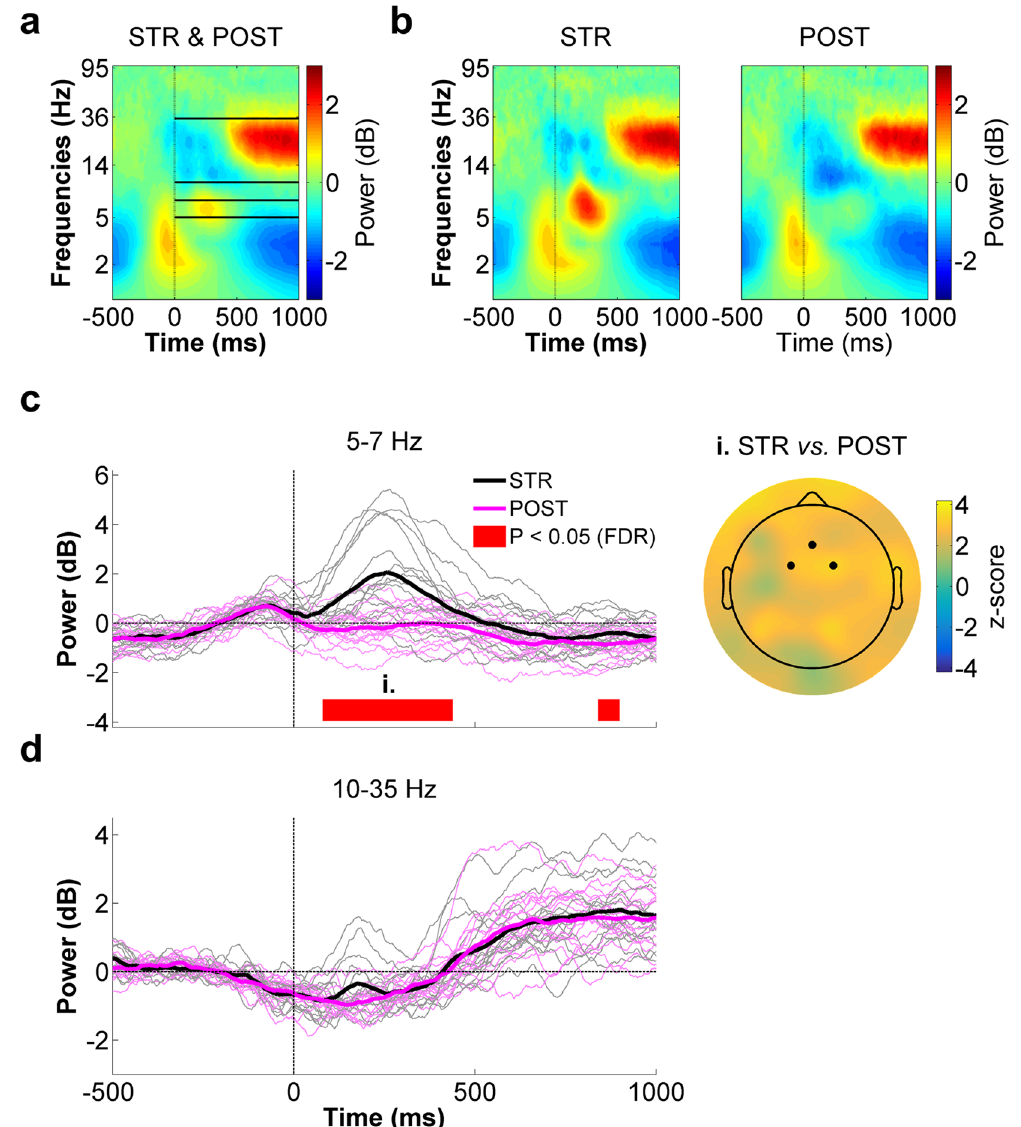
Figure 8. Mid-frontal ROI time-frequency data for STR vs . POST. ( a ) Spectrogram representing the mean ERSPs for STR and POST. The solid lines delimit the frequency bands selected for statistical analyses ( i.e . 5–7 Hz and 10–35 Hz) Time “0 ms” corresponds to movement onset. ( b ) STR (left panel) and POST (right panel) ERSPs. ( c ) High theta (5–7 Hz) spectral power time-course for STR (black) and POST (magenta) (left panel). The red line highlights the time bins showing statistically significant differences between STR and POST ( p ≤ 0.05, FDR-corrected). The scalp map (right panel) represents the statistical z-scores across electrodes for high theta power differences between STR and POST during the significant time window (i., 80–440 ms). The highlighted electrodes denote those that make up the mid-frontal ROI (Fz, FC1 and FC2). ( d ) Beta (10–35 Hz) spectral power time-course for STR (black) and POST (magenta). In the left panels of both ( c ) and ( d ), the thin waveforms represent individual participant data, whereas the thick waveforms represent the mean power across